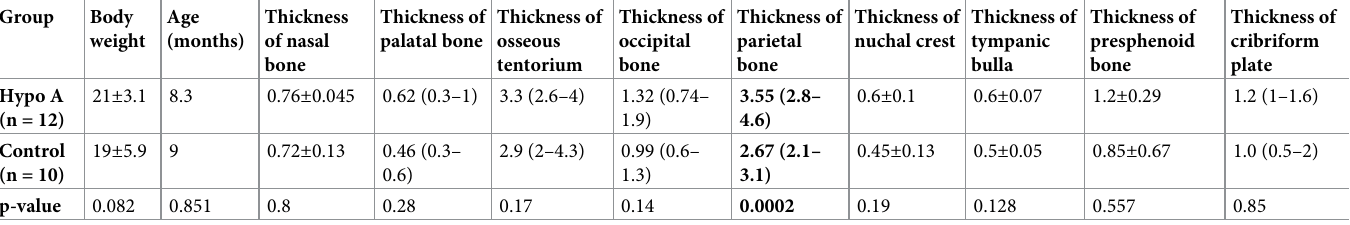
Parameters with significant differences between groups are highlighted in bold